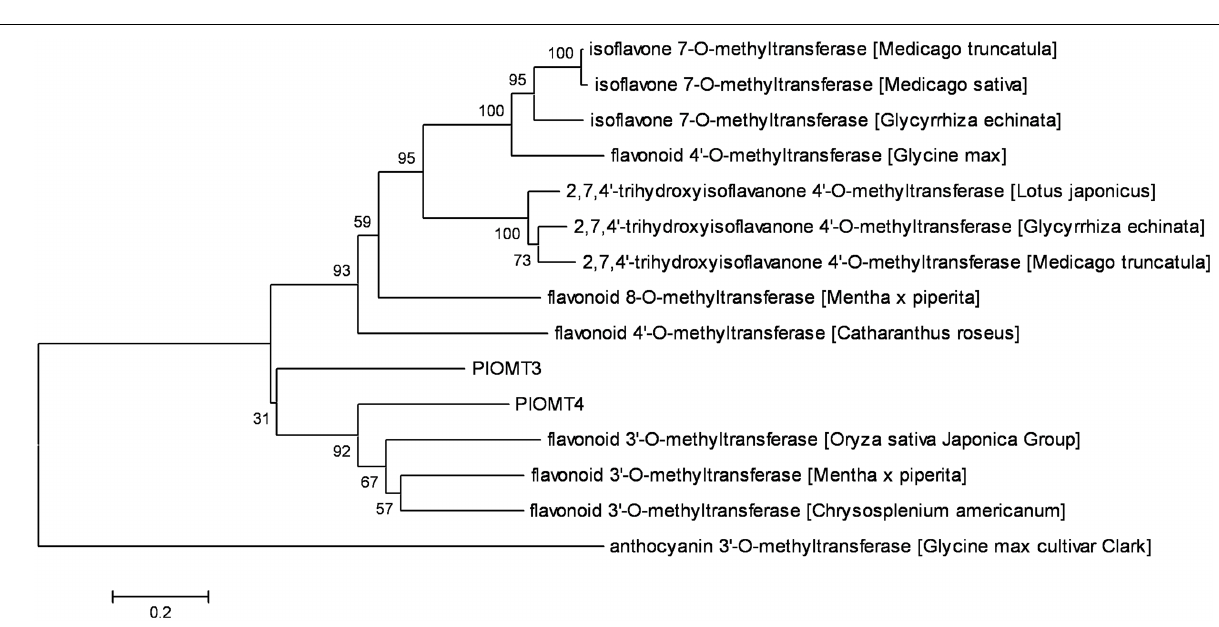
FIGURE 2 | Phylogenetic analysis of the P. lobata OMT candidates with other related sequences. The tree was constructed by the neighbor-joining method of MEGA 6.0. Numbers on each node indicate the bootstrap values of 1000 replicates. The scale bar represents 0.2 amino acid substitutions per